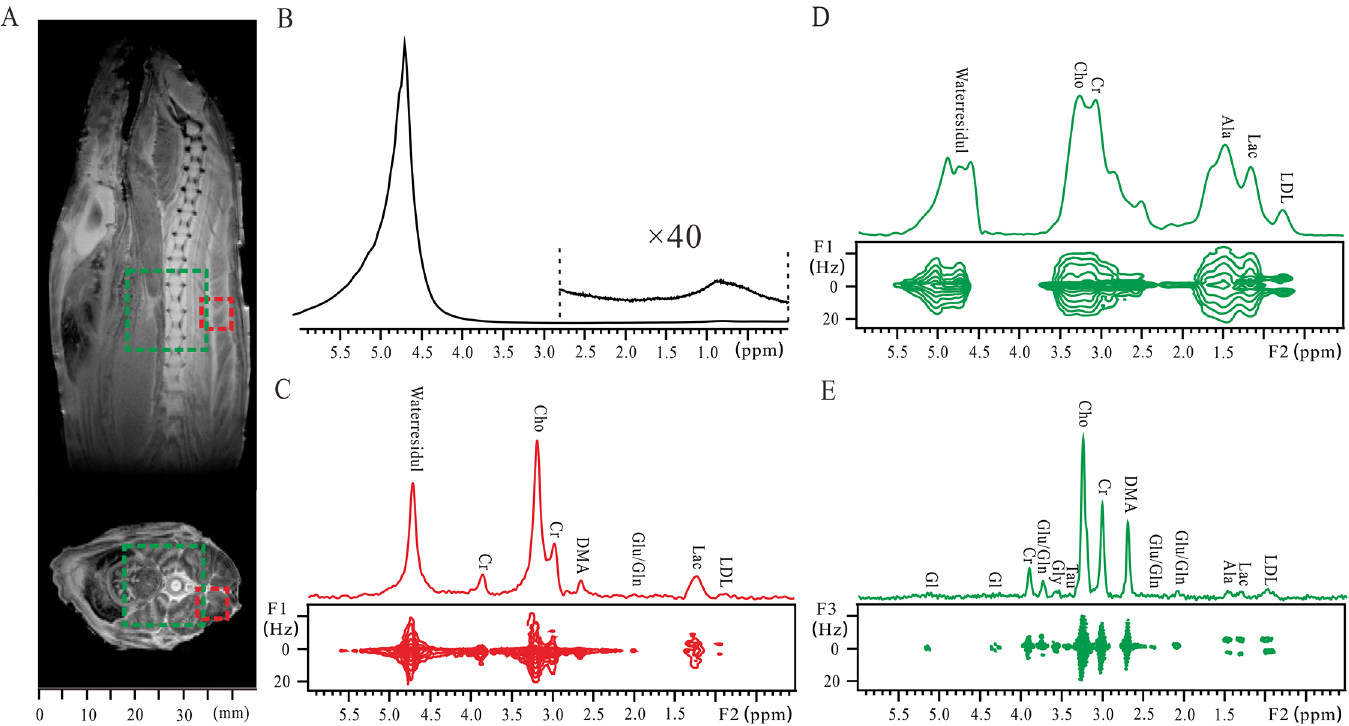
Fig 4. Results of a whole fish ( Harpadon nehereus ). (A) Spin echo images of the fish. A large voxel of 16 × 16 × 16 mm 3 containing the fish spinal cord is marked by a green dashed box, and a small voxel of 6 × 6 × 6 mm 3 containing the fish tissue is marked by a red dashed box. (B) Conventional 1D non- localized spectrum and its expanded region for metabolites. (C) Conventional 2D J PRESS spectrum after a clockwise rotation of 45° and its projection along the F2 axis acquired from the small voxel after the field shimming procedure. (D) Conventional 2D J PRESS spectrum after a clockwise rotation of 45° and its projection along the F2 axis acquired from the large voxel after the field shimming procedure. (E) 2D localized iDQC J RES spectrum and its 1D J -decoupled projection along the F3 axis acquired from the large voxel without the field shimming procedure.